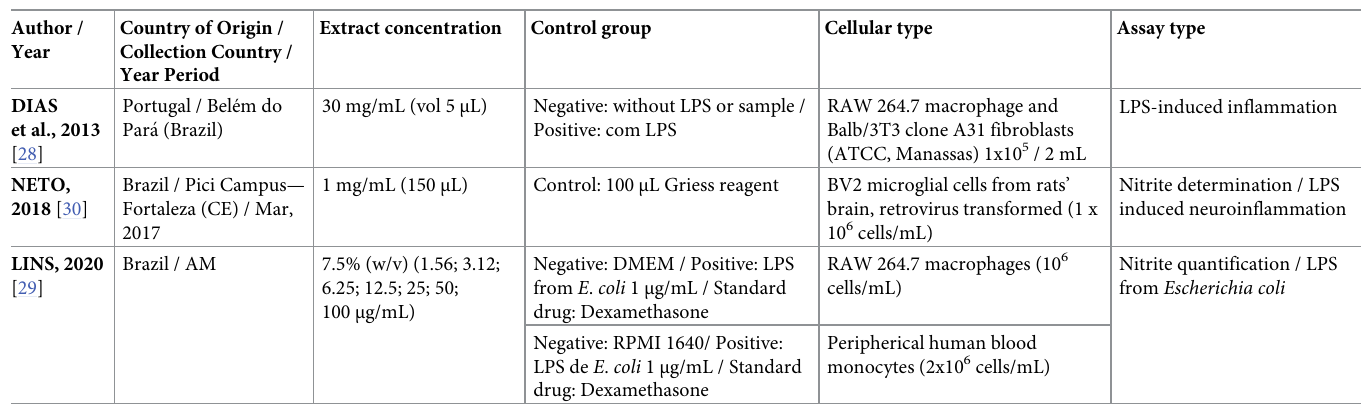
Table 4. General characteristics of in vitro studies.